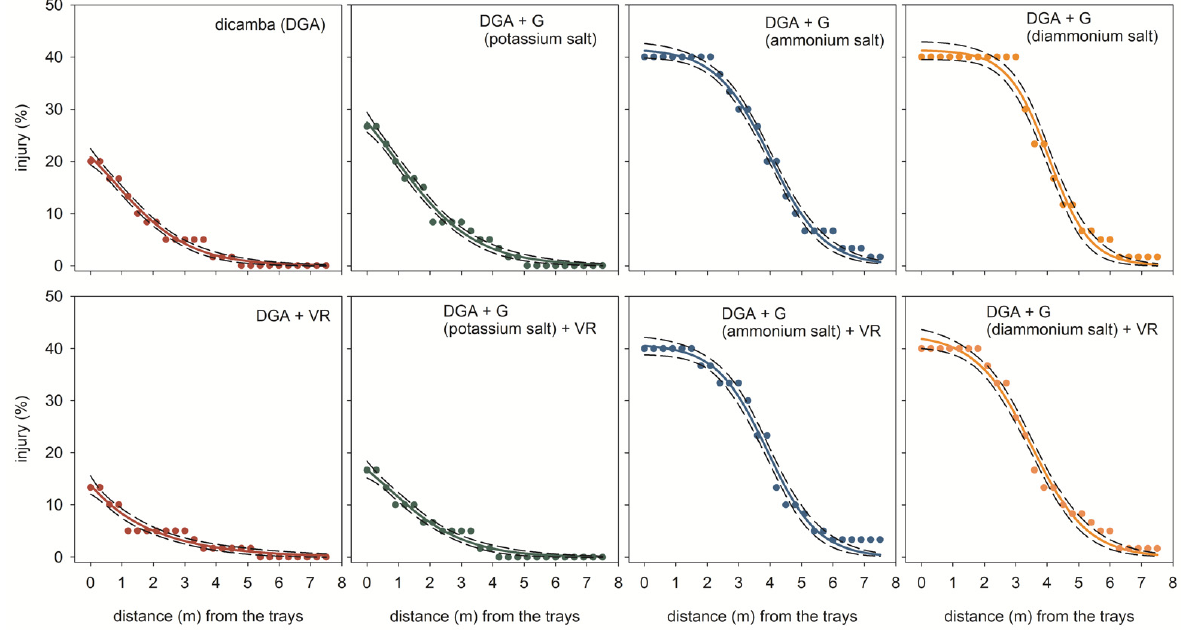
Figure 4. Soybean injury (%) for the different treatments in plants at different distances (m) from the trays treated with dicamba and allocated within the low tunnels. DGA: y = 31.70/(1 + exp ( − (x − 0.78)/ − 1.19)), r 2 0.98; DGA+VR: y = 33.14/(1 + exp ( − (x − 10.87)/ − 1.98)), r 2 0.94; DGA + G potassium